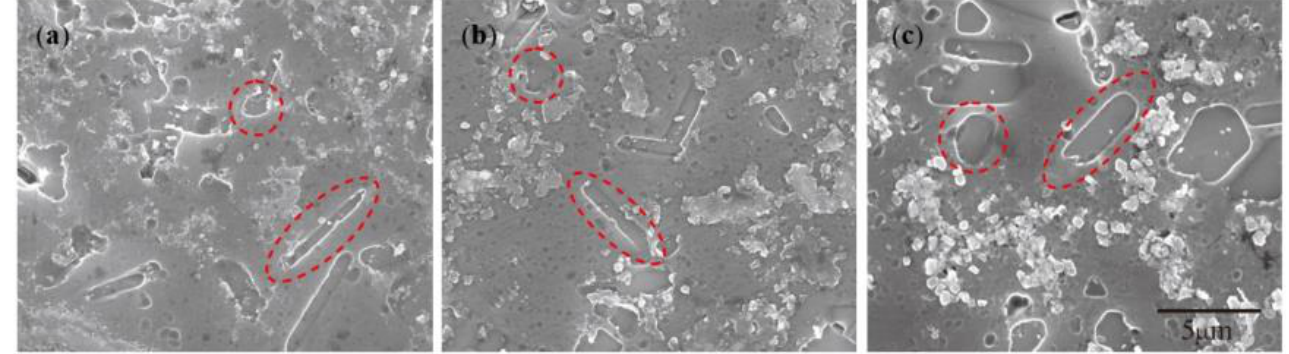
Figure 4. Morphology of TiAl 3 in the Al – Ti – B Master Alloy prepared by the halide salt route after ◦ C: ( a ) 15 S; ( b ) 30 S; ( c ) 60 different reaction times at 800 °C: ( a ) 15 S; ( b ) 30 S; ( c ) 60 S. different reaction times at 800